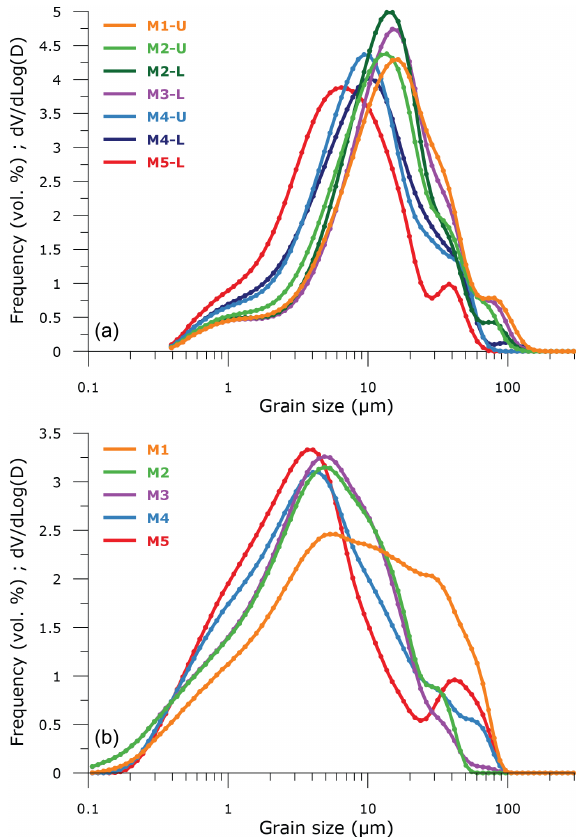
Figure 4. (a) Average volume grain-size distributions of 24 samples from all seven sediment traps, where U is the upper trap (1200m) and L the lower trap (3500m). Collected between October 2012 and November 2013. (b) Grain-size distributions of seafloor sediments at the five mooring stations (M1–M5) along the trans-Atlantic tran-